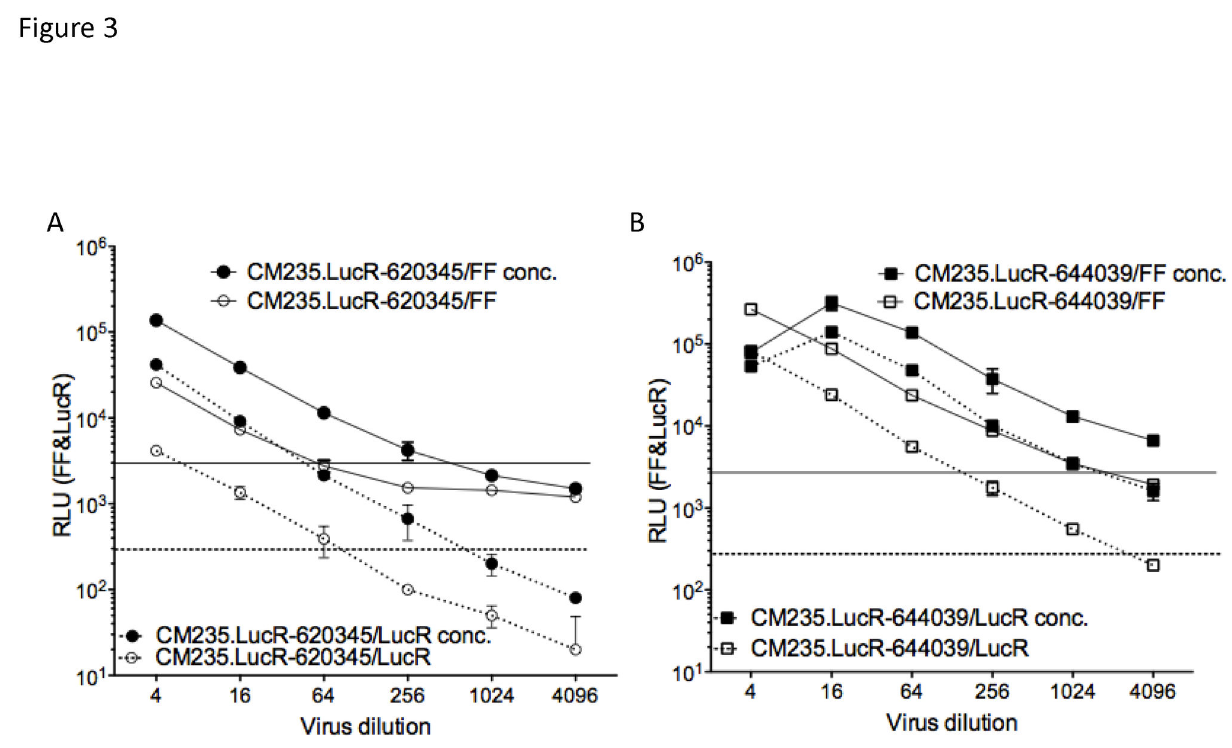
Figure 3. Titrations in TZMbl cells of chimeric IMC.LucR before and after concentration. We measured CM235.LucR-620345 (A) and CM235.LucR-644039 (B) concentrated (open symbols) and original (plain symbols) virus stocks. Titrations were performed in duplicate, in a 4-fold dilution format, in TZM-bl cells. Firefly luciferase acitivity (RLU FF, bold lines) and Renilla luciferase activity (RLU LucR, dashed lines) were measured simultaneously in the same wells, 48 hours later. Horizontal solid and dashed lines indicate the cut-off values for FF and LucR,